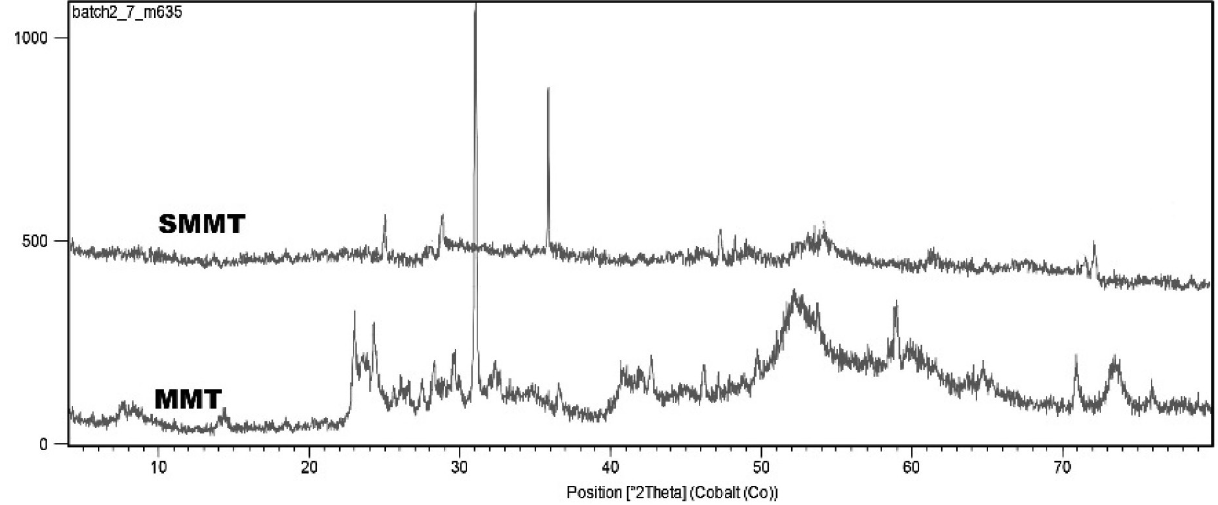
Figure 4. The XRD images of MMT and SMMT